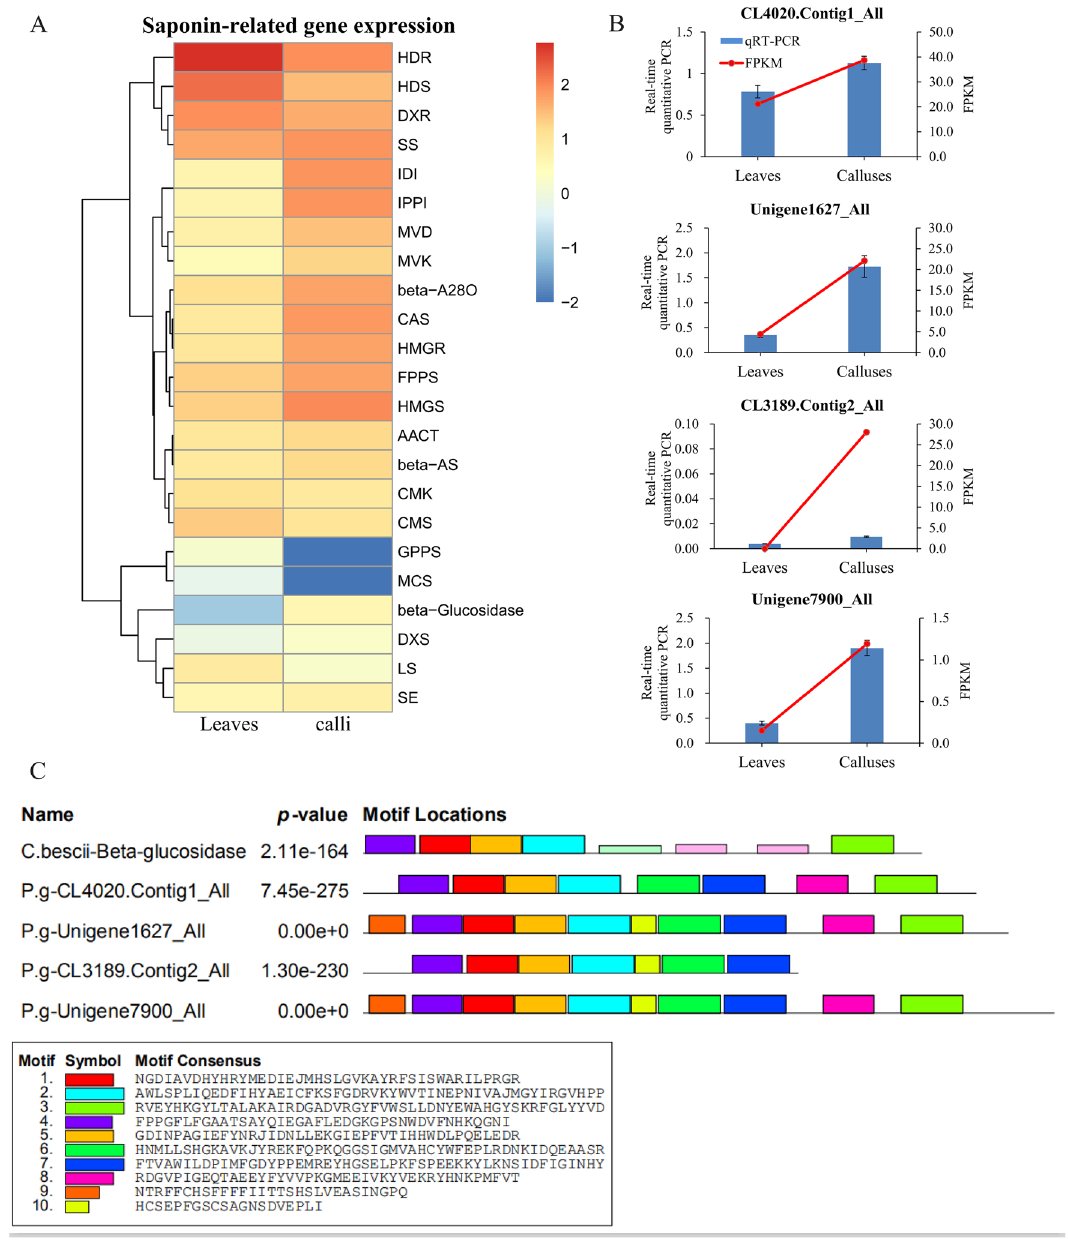
Figure 5. Expression level analysis of genes from triterpenoid saponins biosynthetic pathway in P . grandiflorus and conserve motif analysis of predictive β-glucosidase. ( A ) The expression levels of a single gene encoding an enzyme from each step of triterpenoid saponins biosynthetic pathway are shown. Red and green represent high and low expression levels, respectively. ( B ) Real-time quantitative PCR analysis of CL4020.Contig1_All, Unigene 1627_All, CL3189.Contig2_All and Unigene7900_All in leaves and calli. 18S rRNA as internal reference gene. Error bars indicate SD (n = 3). The blue bars represent the real-time quantitative PCR data and the red line represents the FPKM value from RNA-Seq. ( C ) Comparison of the conserve motifs among β-glucosidase from C . bescii and the amino acid sequences of putative orthologous unigenes from P . grandiflorus . Each block shows the position and strength of a motif site. The height of a block gives an indication of the significance of the site as taller blocks are more significant. The height is calculated to be proportional to the negative logarithm of the p-value of the site, truncated at the height for a p-value of